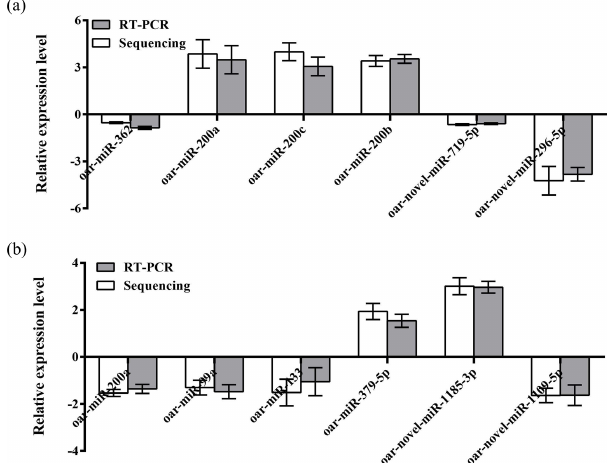
Figure 3. Validation of the Solexa sequencing results in the ovarian and uterine libraries. Data are mean ± SEM. Panels (a) and (b) show ovary and uterus libraries,